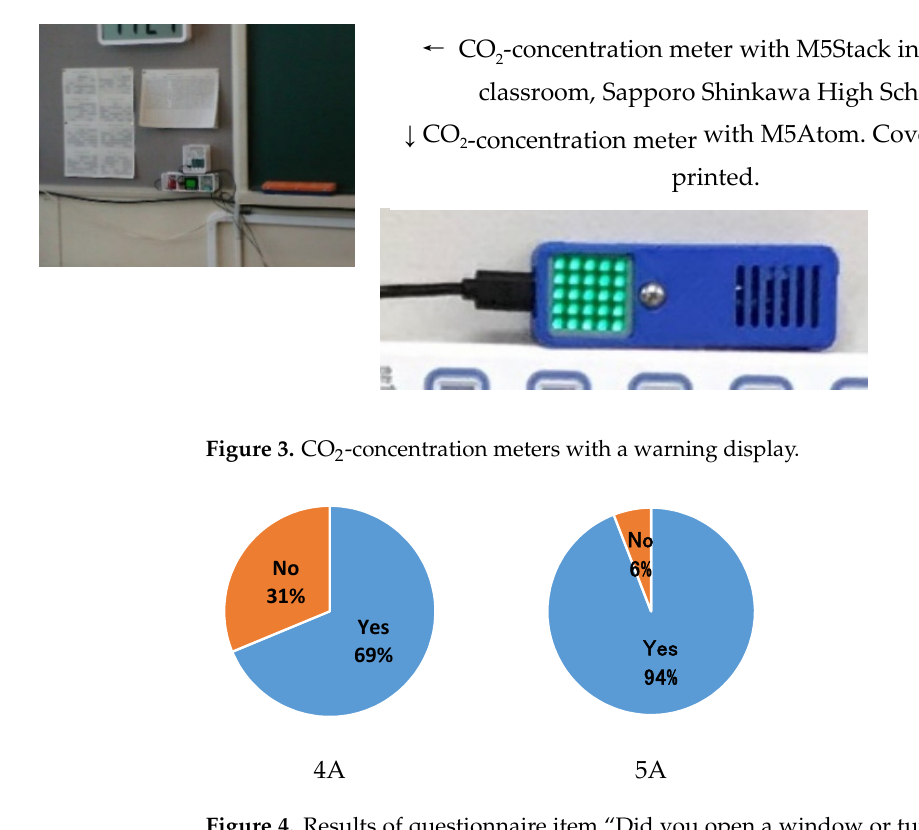
Figure 4. Results of questionnaire item “Did you open a window or turn on ventilation when the display alerted you?”.